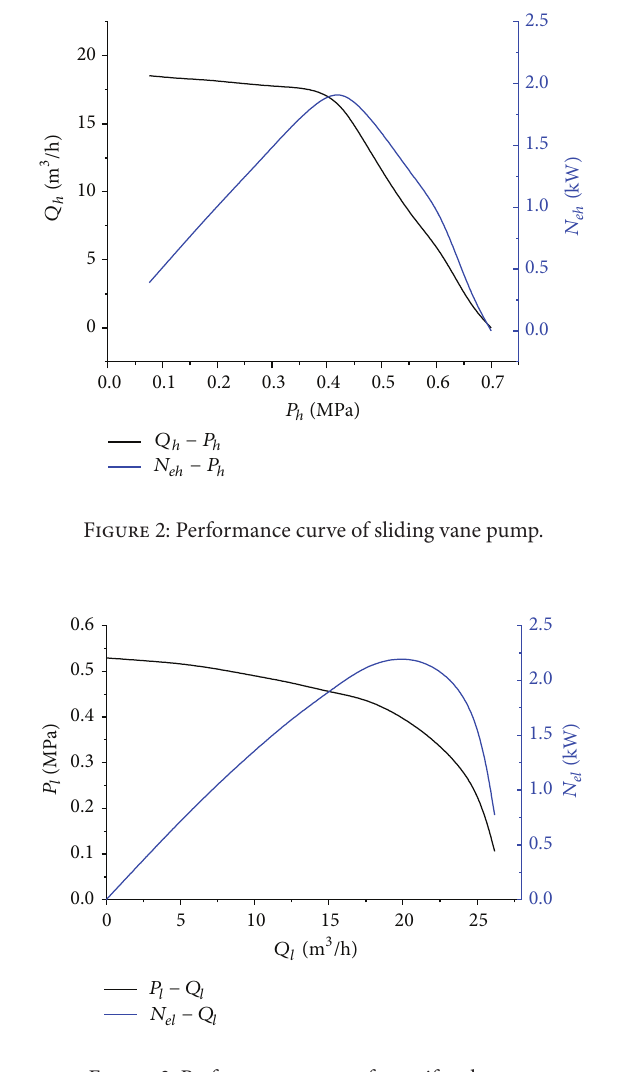
butterfly valve of the by-pass pipeline on the outlet of centrifugal pump. Observe the liquid flow through sight glass.